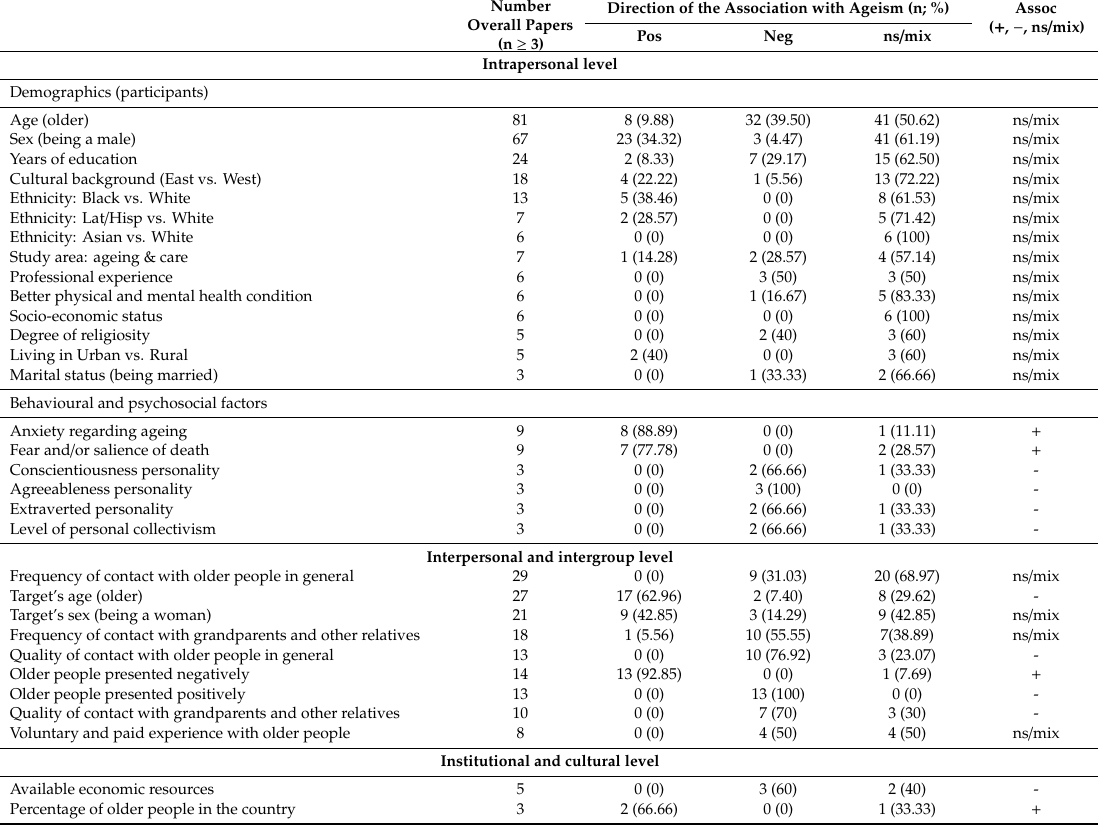
Table 2. Determinants of “other-directed forms of ageism” (total N =